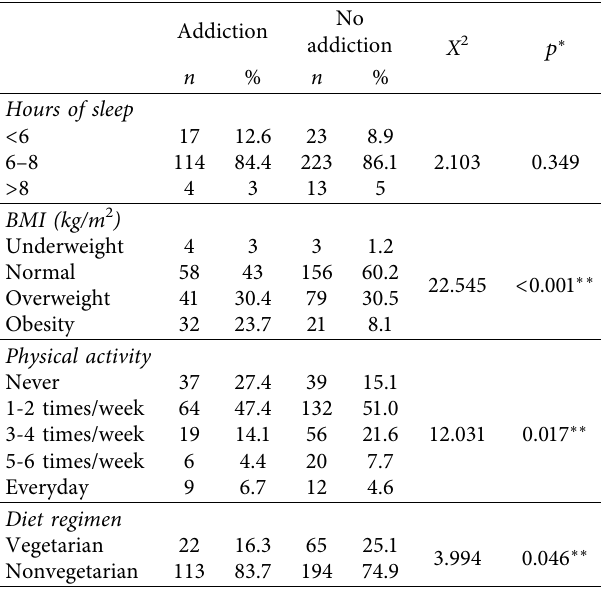
Table 2: Hours of sleep, BMI, physical activity, diet, and food